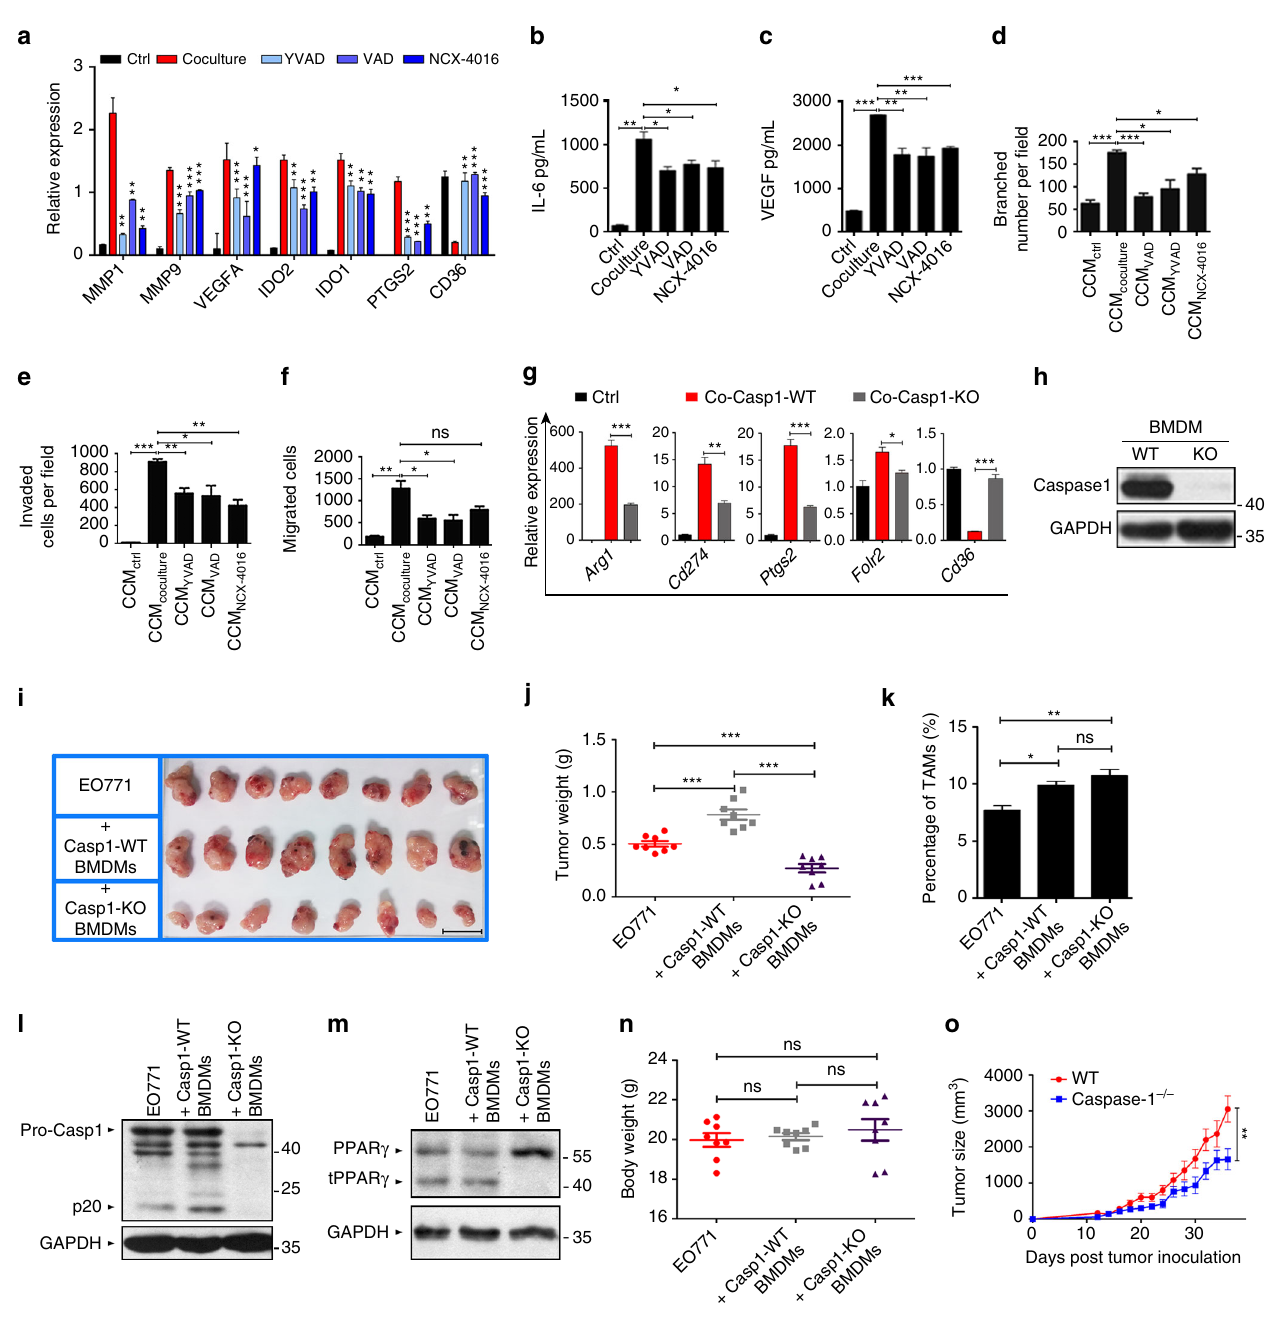
Fig. 2 Caspase-1 inhibition prevents PPAR γ cleavage and then blocks TAM differentiation. a THP-1 cells were cultured alone or cocultured with MCF-7 or cocultured in the presence of YVAD, VAD or NCX-4016 for 48 h, and the expression of pro-tumoral genes and CD36 were assessed by RT-qPCR ( n = 3). pro-migration ability of CCM Ctrl , CCM Coculture , CCM YVAD , CCM VAD and CCM NCX-4016 was tested ( n = 3). g Peritoneal macrophages were isolated